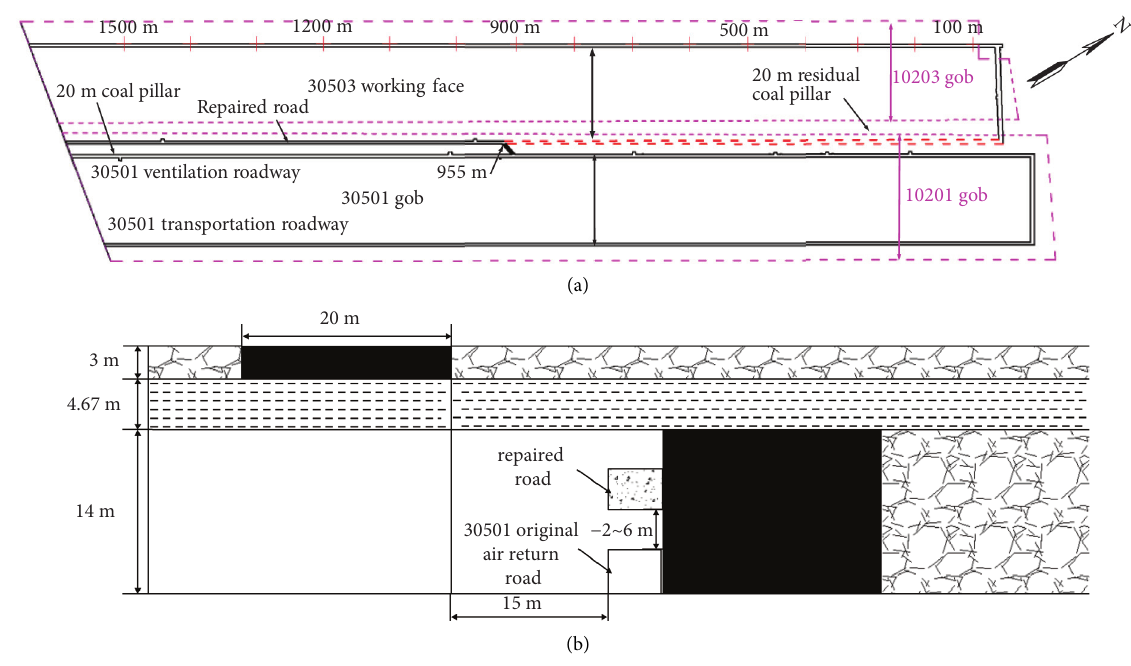
Figure 1: The layout of the 30503 working face. (a) Plan. (b) Elevation.